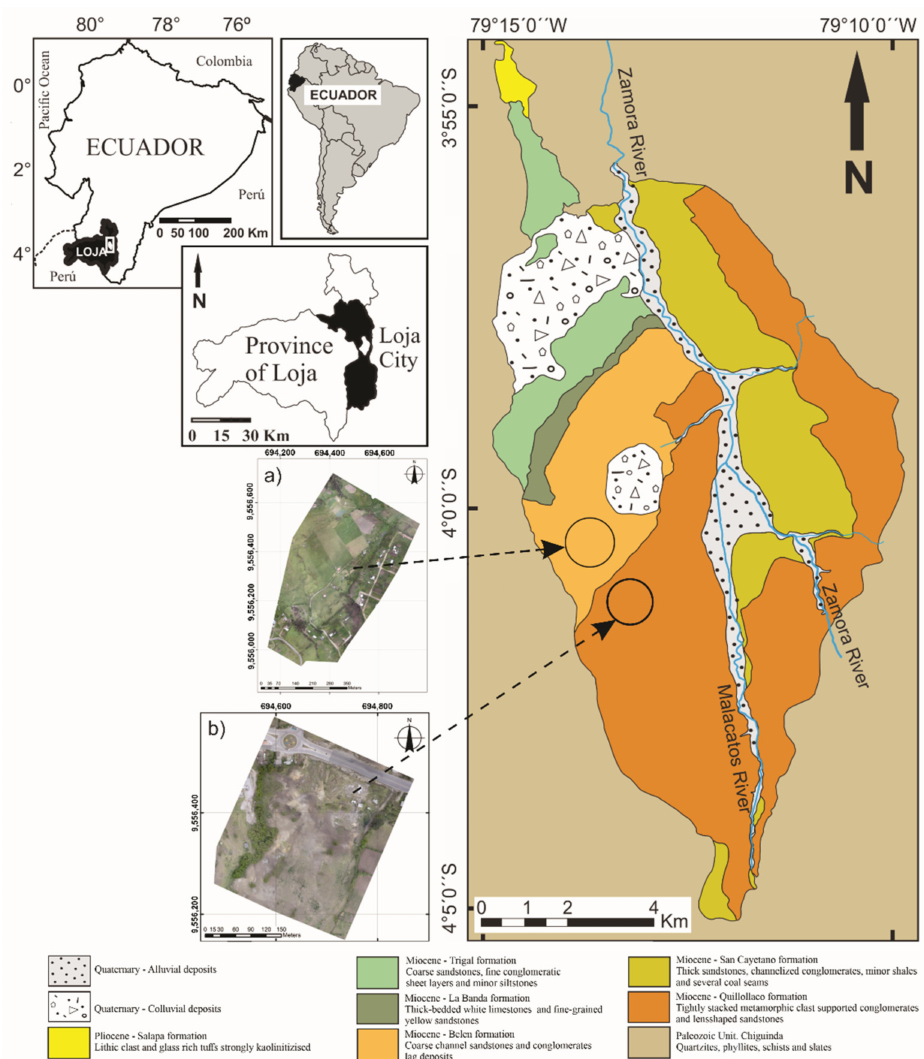
Figure 1. Locations and geological frameworks of the study areas: ( a ) Victoria and ( b ) Colinas Lojanas. Adapted from Soto et al.